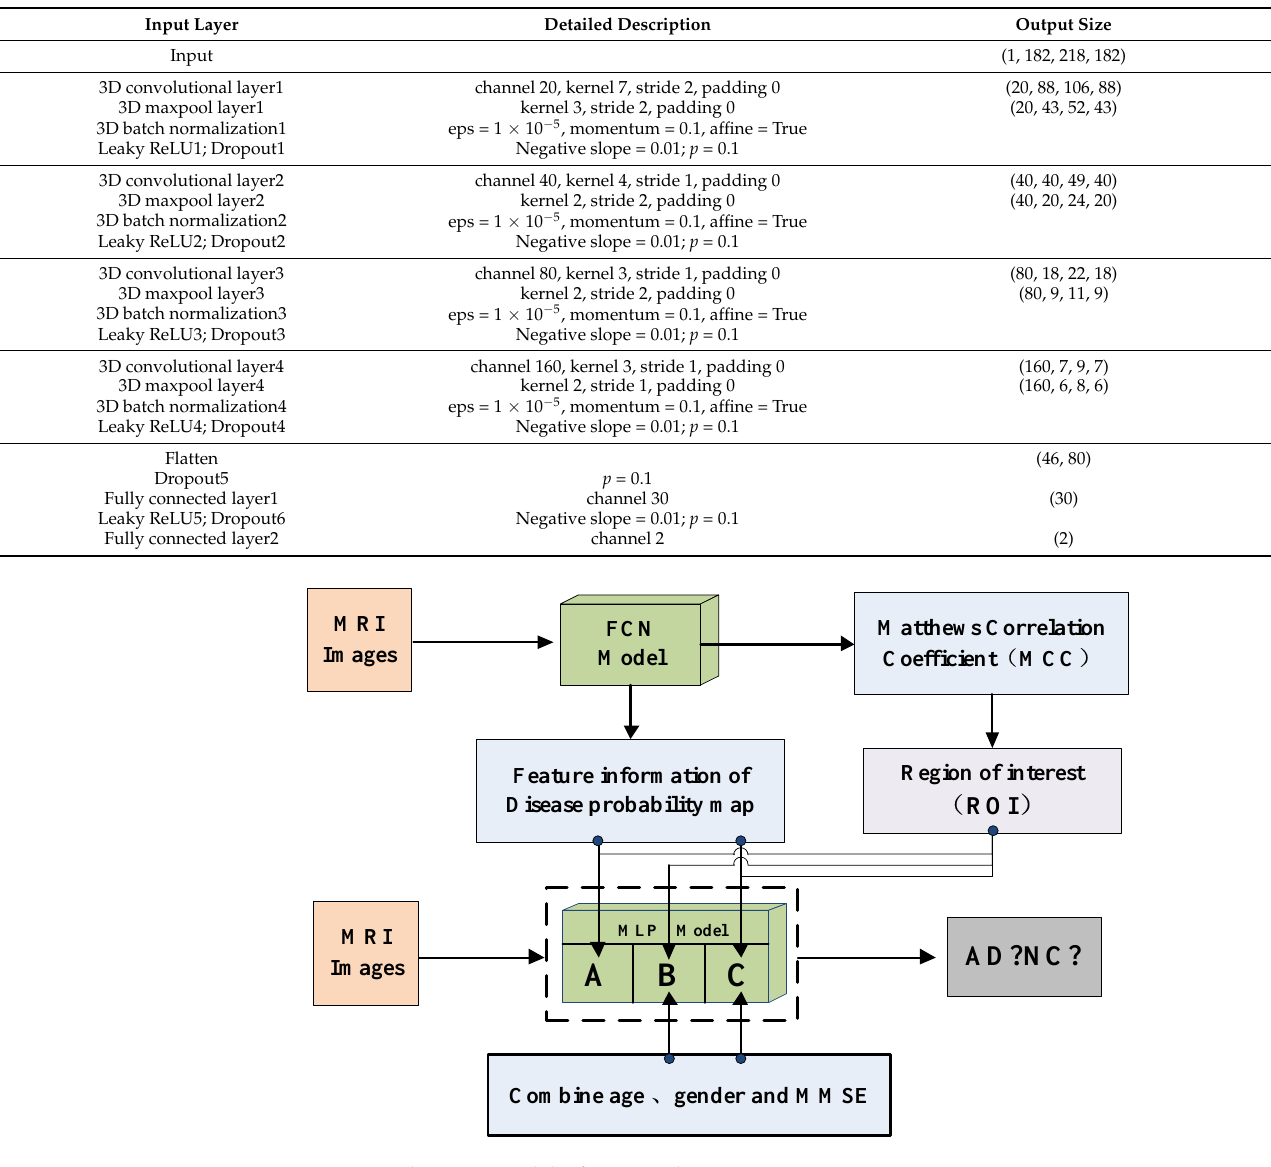
Figure 9. The MLP model’s framework.